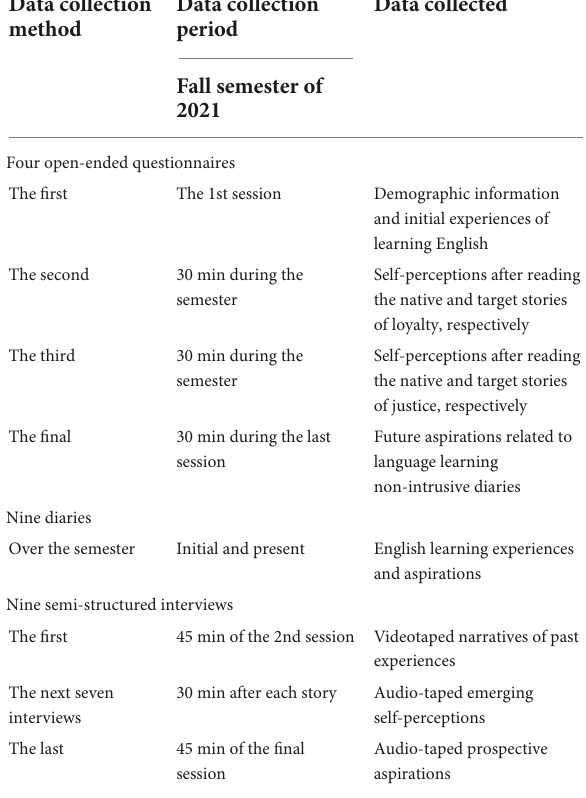
TABLE 2 Data collection through interviews, diaries, and questionnaires.